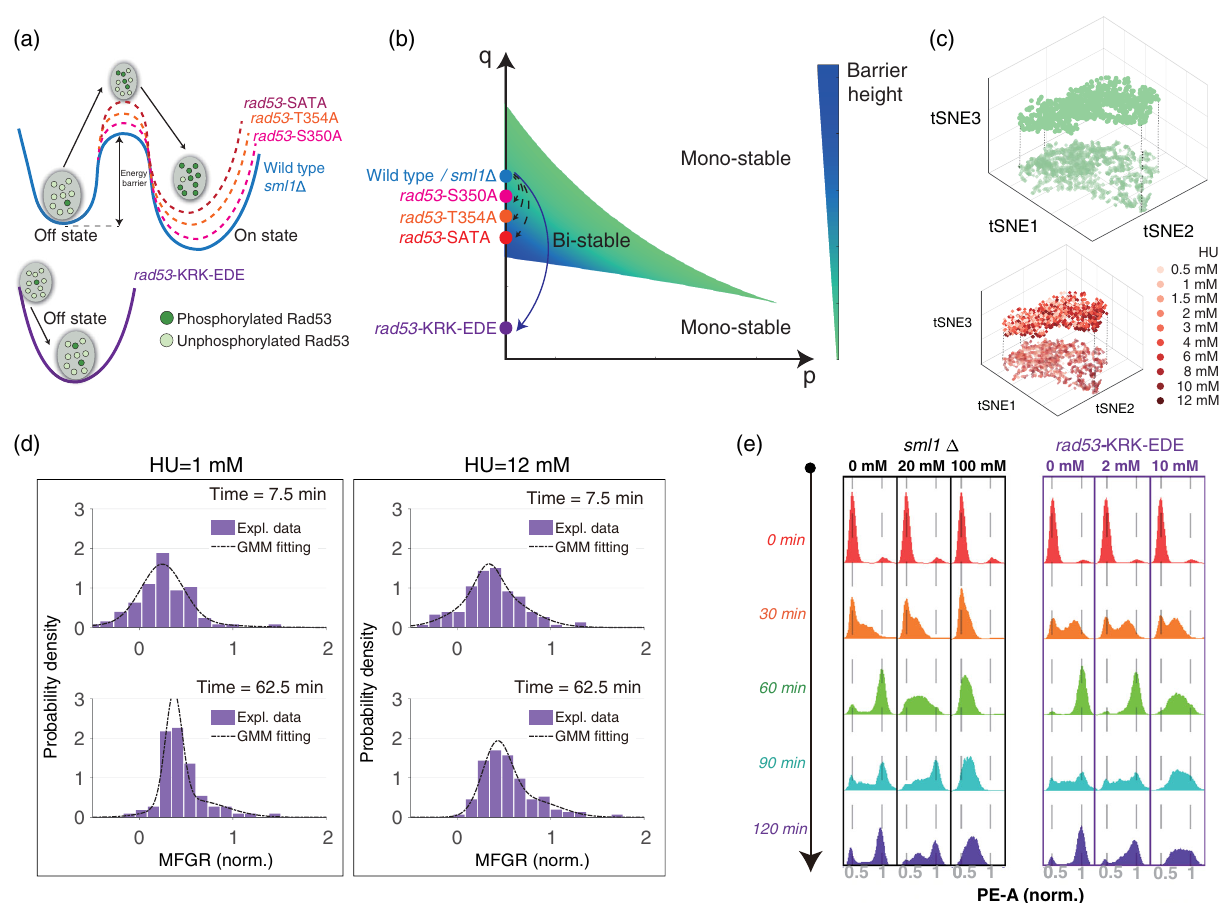
FIG. 5. Quasipotential perspective for bimodal and unimodal distribution in rad53 mutants. (a) Quasipotential landscape perspective for the activation process of the yeast S-phase checkpoint. The off and on states correspond to the two potential wells in the quasipotential landscape, and the activations need to cross the potential barrier between the off state and the saddle state. The dimeric Rad53 binding the surface mutant rad 53 -KRK-EDE demonstrates the potential landscape without a potential barrier, which displays a unimodal distribution of MFGR. (b) Dependence of barrier heights in the off-to-on switches on the parameters p (signal intensity) and q (Rad53 autophosphorylation intensity) in the stochastic model. The increase of HU concentration will lower the barrier height to enable switching and facilitate the transition, while the suppression of autophosphorylation will increase the potential barrier and impede the transition. The corresponding q values of various mutant strains are marked on the map. (c) Raw data of a time series with various HU doses, processed by the t-SNE dimensionality reduction method. (d) Unimodal distribution of normalized MFGR of the rad 53 -KRK-EDE mutant for 1-mM and 10-mM HU every 5 min. (e) Flow chart of rad 53 -KRK-EDE strain and sml 1 Δ strain cultured at different concentrations of HU. All cells are synchronized in the G1 phase by a α factor at 0 min. It can be observed that the rad 53 -KRK-EDE mutant is arrested in the S phase under HU ¼ 10 mM, suggesting its relatively poor tolerance to high HU